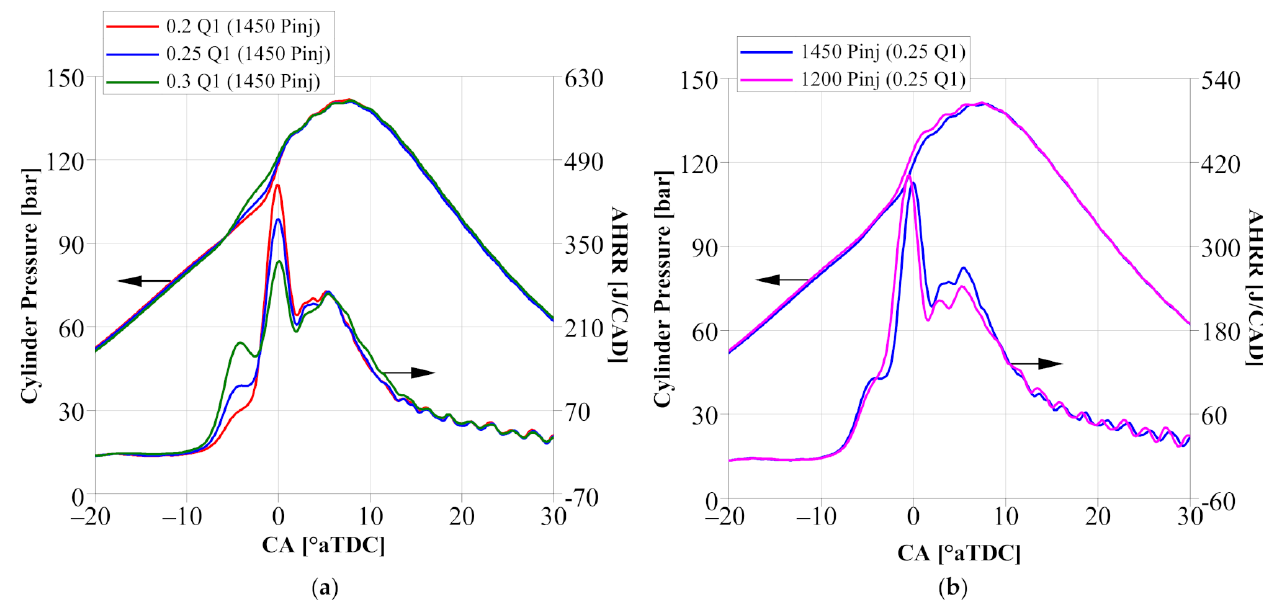
Figure 16. Global combustion behavior under varying fuel injection strategies at B50: ( a ) impact of Q1; ( b ) impact of Pinj.